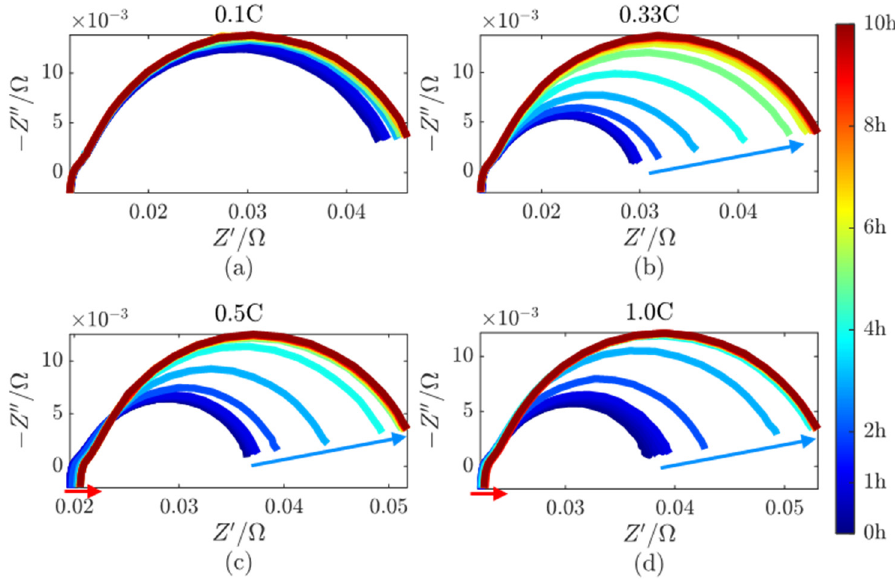
Figure 2. The electrochemical impedance spectrum of ( a ) experiment #1-1; ( b ) experiment #1-2; ( c ) experiment #1-3; ( d ) experiment #1-4. Table 4. Detailed setup of DRT